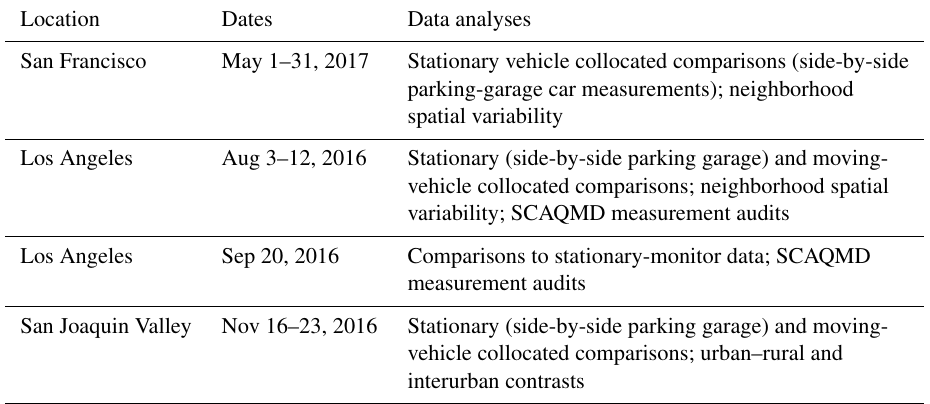
Table 2. Data sets used to evaluate spatial variability and to address individual research questions, including measurement uncertainty.